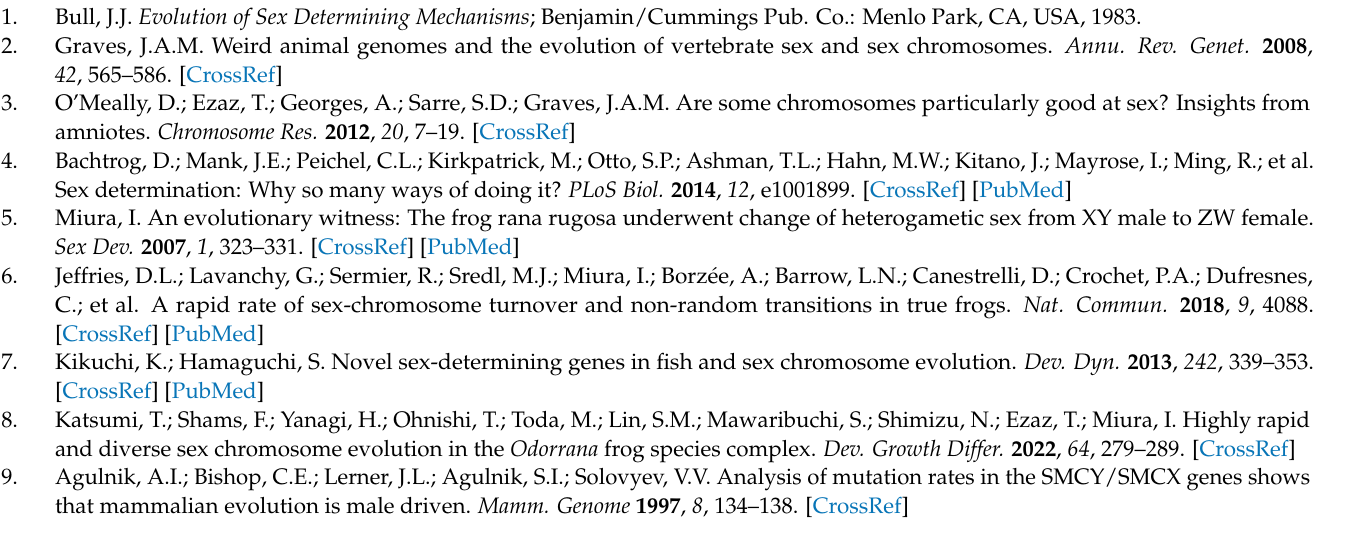
Table S1: List of sex-linked genes from three different clusters. Table S2: Allelic expression of the sex-linked genes based on the data of RNA-Seq analysis in three tissues from the XY male and XX female in the XY system and ZZ male and ZW females in the ZW